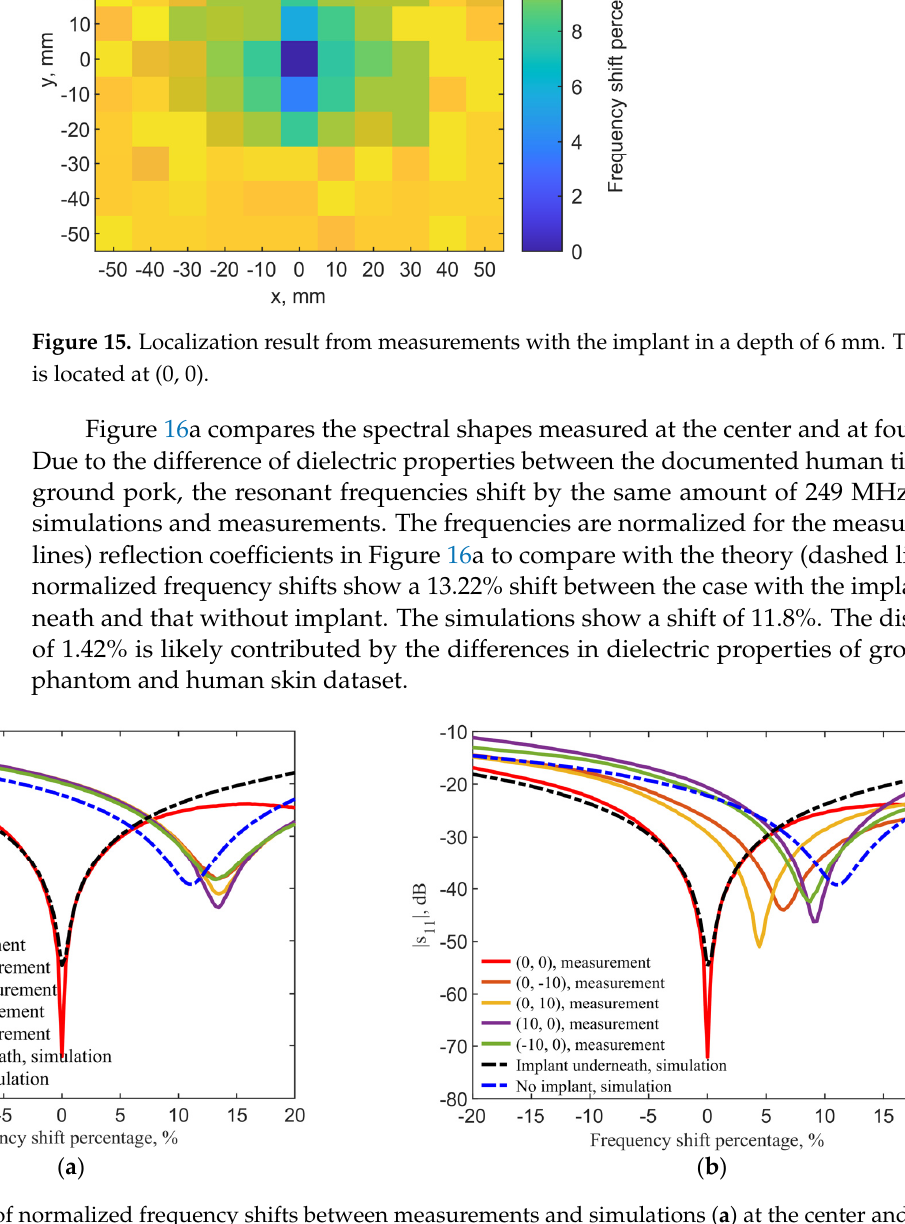
Figure 14. Localization maps with the transmitter loop in different depths of 6, 9, 12, and 15 mm: ( a ) at the orientation where the ports are aligned, and ( b ) at a rotated orientation of port by 90° from the cases in ( a ).